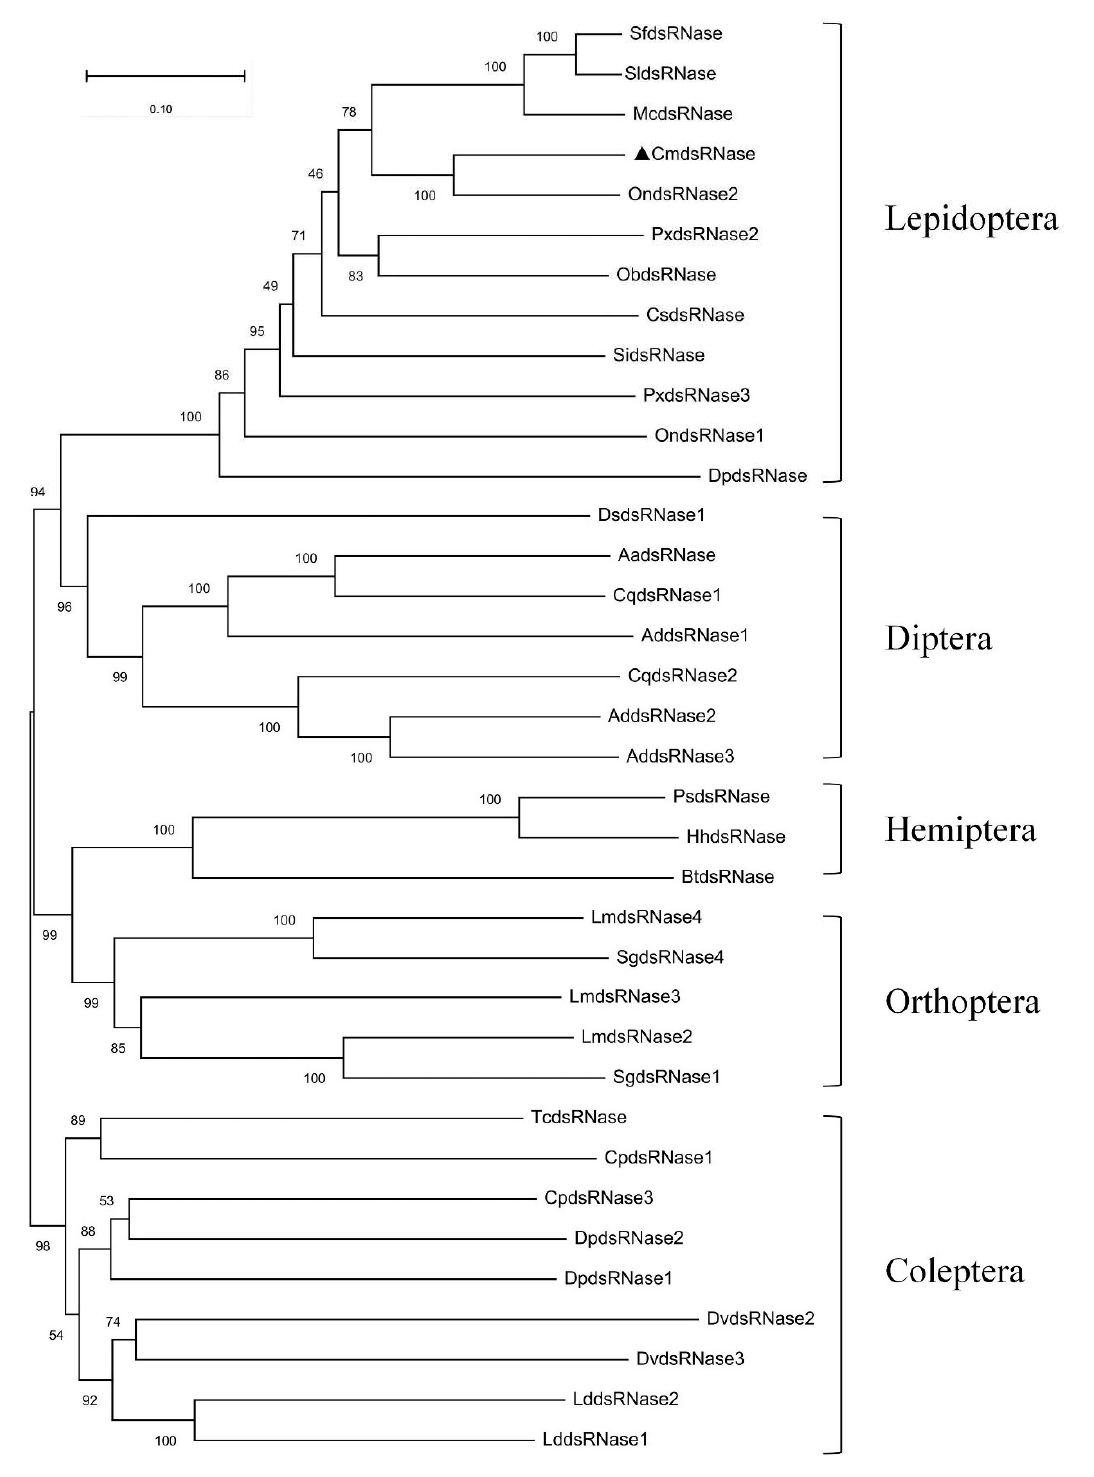
Figure 4. An evolutionary tree of insect dsRNases. Bootstrap values are marked at internal nodes and CmdsRNase is labeled with a solid triangle. The species name and GenBank accession number corresponding to each sequence are as follows. Lepidoptera: SfdsRNase, Spodoptera frugiperda (CAR92521.1); SldsRNase, S. litura (QJD55608.1); McdsRNase, M. configurata (AEA76311.1); OndsRNase1, O. nubilalis (QOE54913.1); OndsRNase2, O. nubilalis (QOE54910.1); PxdsRNase2, Plutella xylostella (QZW25238.1); PxdsRNase3, P. xylostella (QZW25239.1); ObdsRNase, Operophtera brumata (KOB65521.1); CsdsRNase, Chilo suppressalis (AKB95584.1); SidsRNase, Sesamia inferens (AKB95590.1); DpdsRNase, Danaus plexippus plexippus (OWR44806.1). Diptera: DsdsRNase1, Dro-